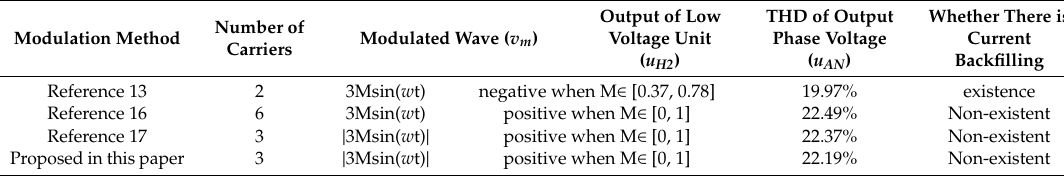
Table 1. Comparison of different modulation method.